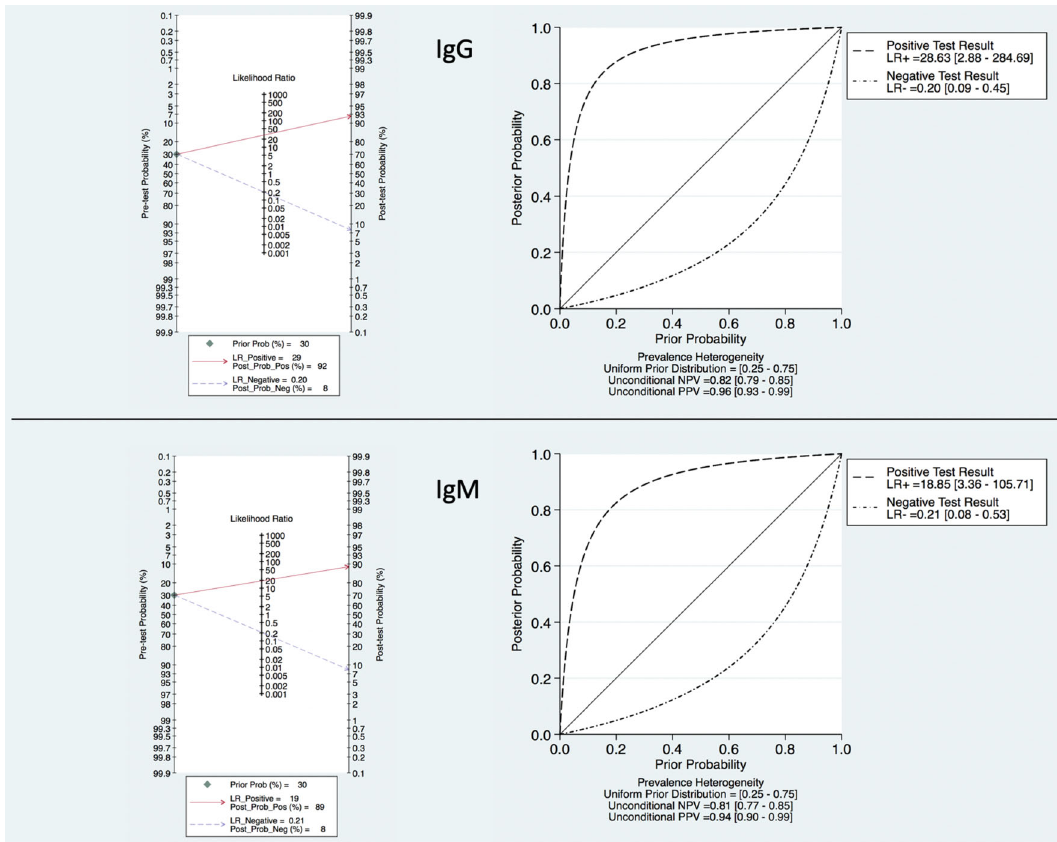
Figure 4 - Fagan Nomogram and Probability Modifying